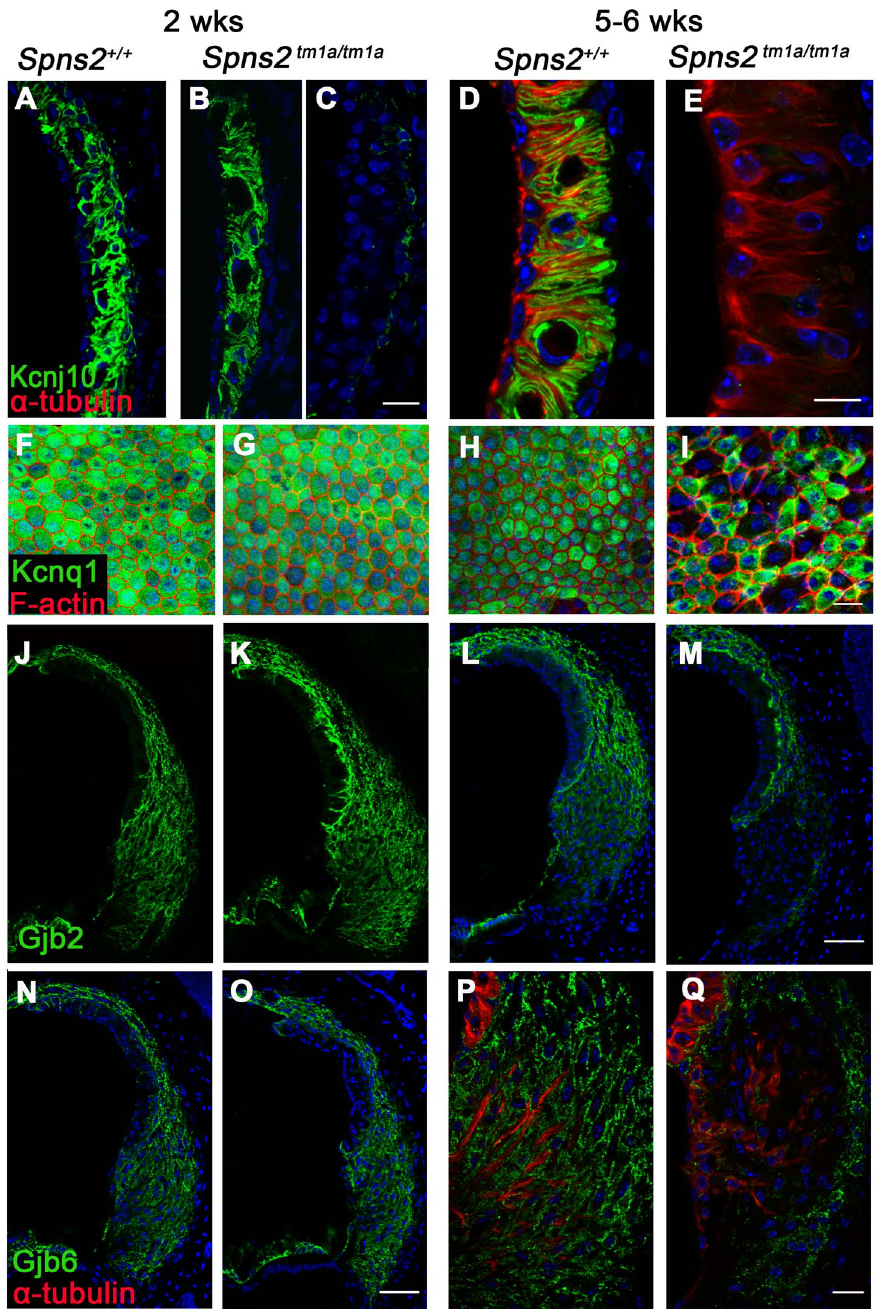
Figure 8. Progressive decrease in expression of Kcnj10, Kcnq1, Gjb2 and Gjb6 in Spns2 tm1a/tm1a mice. A–E : At P14, Kcnj10 expression (green) of homozygotes was comparable to that of wildtype in apical turns, while in basal turns, some appeared normal ( B ) as wildtype ( A ), but some appeared largely reduced ( C ). At 5–6 weeks old, Kcnj10 labelling was absent in homozygotes ( E ). Acetylated a -tubulin (red) was used to label strial marginal cells in D,E . F–I : Whole mount preparations of the stria. Kcnq1 labelling (green) was detected at P14 in both homozygotes ( G ) and wild types ( F ), but it was absent from those marginal cells with enlarged cell boundaries in Spns2 tm1a/tm1a mice at 5–6 wks ( I ). Phalloidin (red) labelled filamentous actin to reveal the boundaries of marginal cells. J–Q : Gjb2 and Gjb6 were present in the fibrocytes of the spiral ligament in both wild type and Spns2 tm1a/tm1a mice at P14 ( J,K,N,O ). At 5–6 wks, expression was absent in the area behind the spiral prominence corresponding to the type II fibrocytes in homozygotes ( M and Q ) compared with wildtypes ( L and P ) of the same age. Root cells were labelled by acetylated a -tubulin (red) in P,Q . DAPI (blue) labelled the nuclei. Scale bar, 10 m m in D,E . 20 m m in A–C , F–I,P,Q . 50 m m in J–O . doi:10.1371/journal.pgen.1004688.g008 and the Pds mutant mouse also shows reduced EP [64], loss of [28]. However, the Pds mutant shows a severe early developmen- expression of Kcnj10 [37] and Kcnq1 [28], and increased tal defect of the inner ear with extensive hydrops [65], which we accumulation of strial pigmentation compared with controls do not find in Spns2 mutants. This indicates that Spns2 -deficient